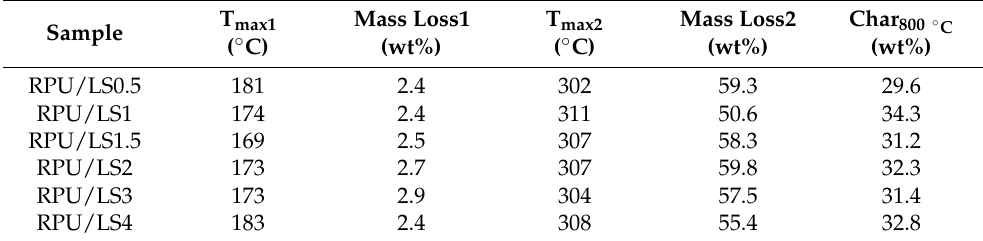
Table 7. TG data of LS ratios as a char forming agent on the thermal stability of RPU/LS